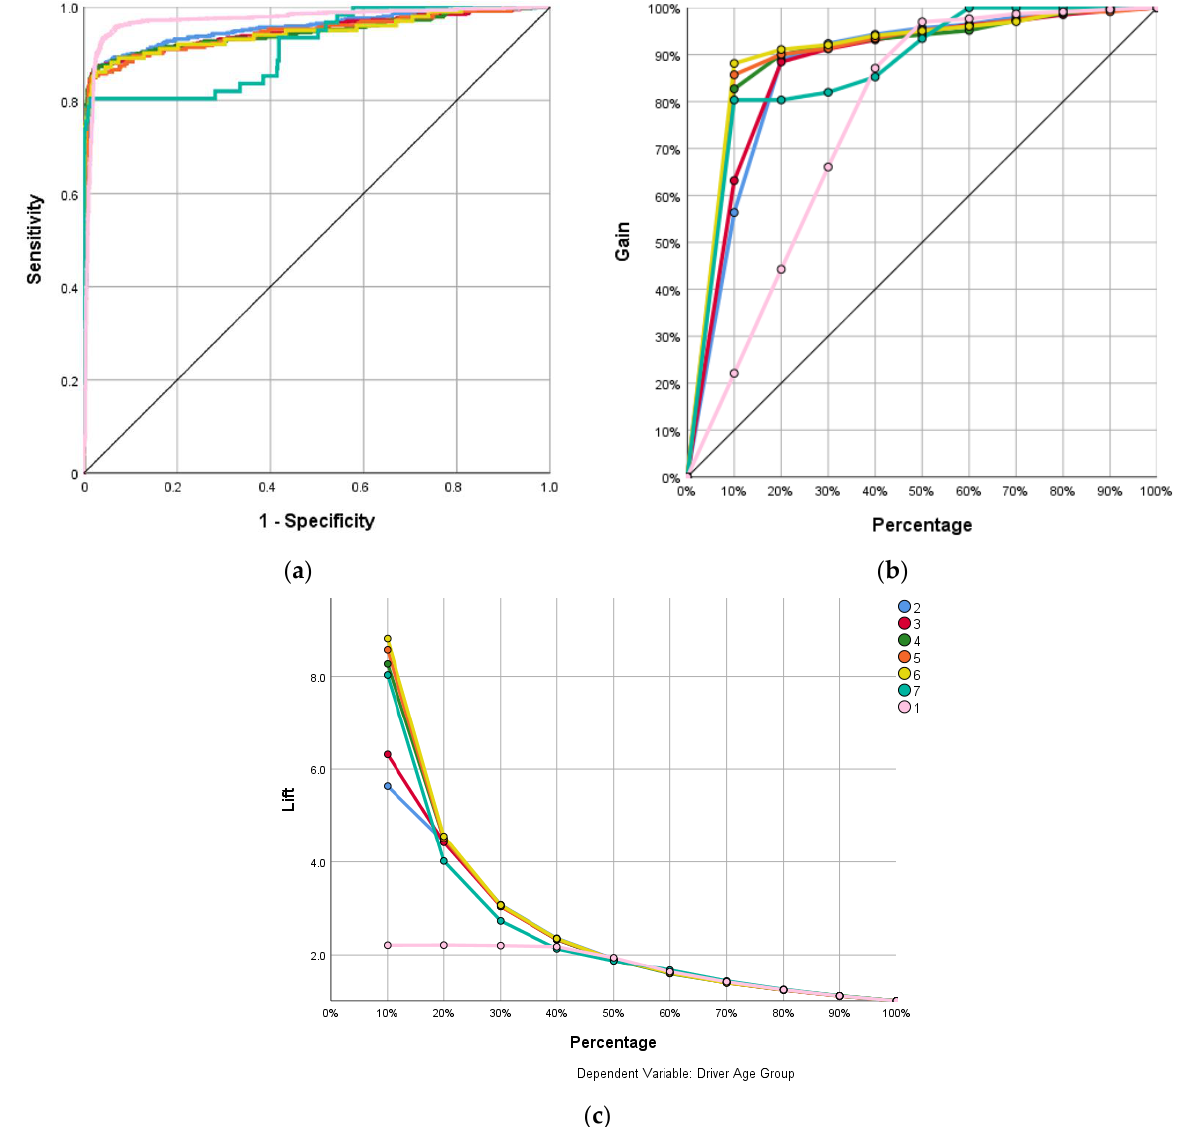
Figure 2. ( a ) ROC curve, ( b ) Gain chart, and ( c ) Lift chart for the constructed predictive deep learning-based model.